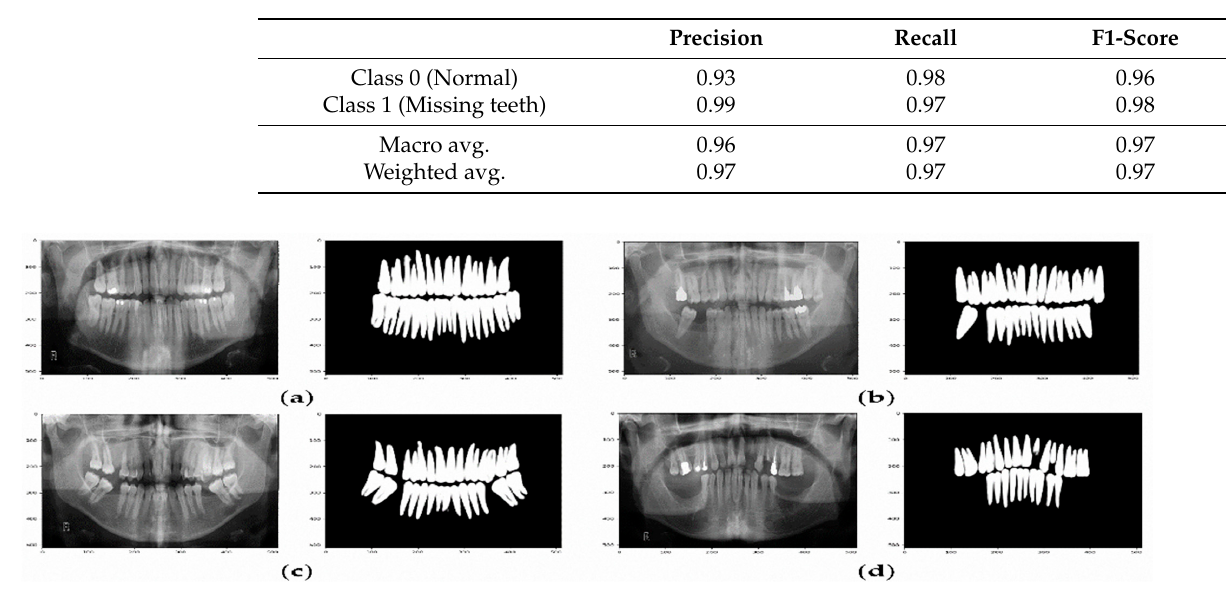
Figure 8. Example of predicted masks using U-Net model. ( a ) The X-ray image and the predicted binary mask for normal teeth. ( b – d ) Various X-ray images and their predicted binary masks for missing teeth.